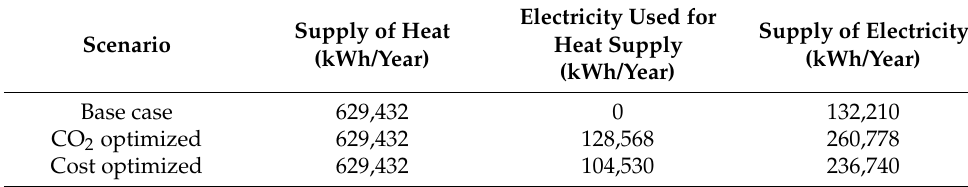
Table 2. Supply of heat and electricity for the different scenarios. Electricity Used for Supply of Heat Supply of Electricity Scenario Heat Supply (kWh/Year) (kWh/Year) (kWh/Year) Base case 629,432 0 132,210 CO 2